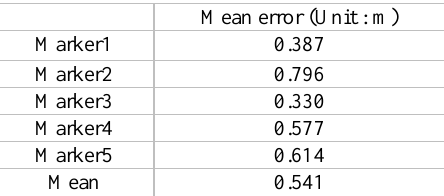
Table3. The average error of every marker